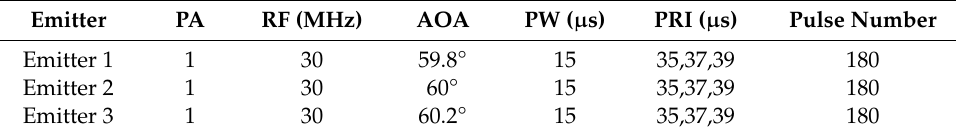
Table 5. Signal parameters of Scene 1.